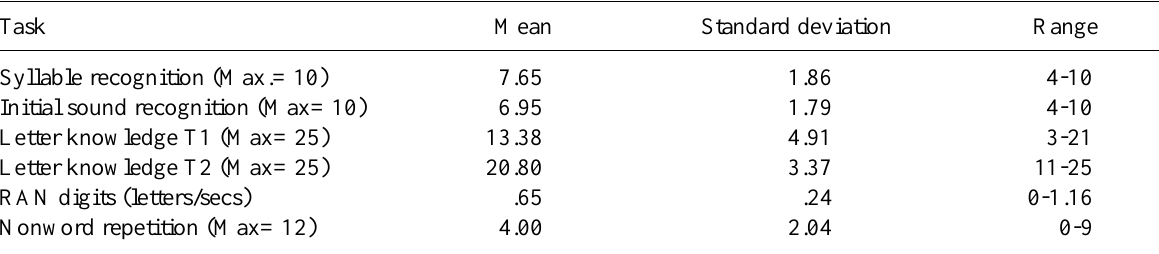
Descriptive Statistics for the Low-skill Group at Beginning and End of Year